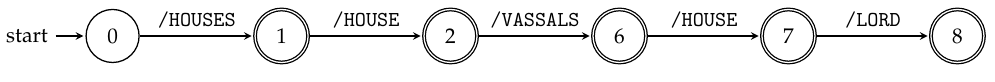
Figure 6. Deterministic prefix automaton for the string path P = HOUSES ( 1 ) HOUSE ( 2 ) VASSALS ( 6 ) HOUSE ( 7 ) LORD ( 8 ) from Example 8.